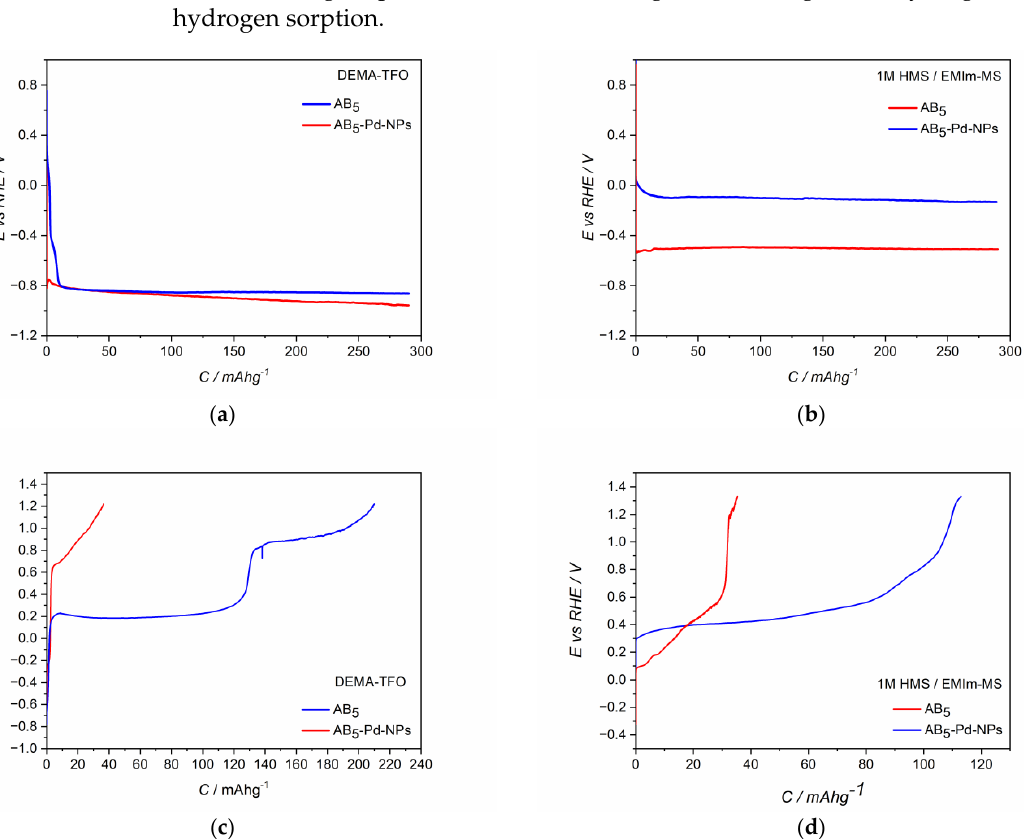
Table 3. Hydrogen absorption capacities calculated from chronopotentiometric discharging. Sample